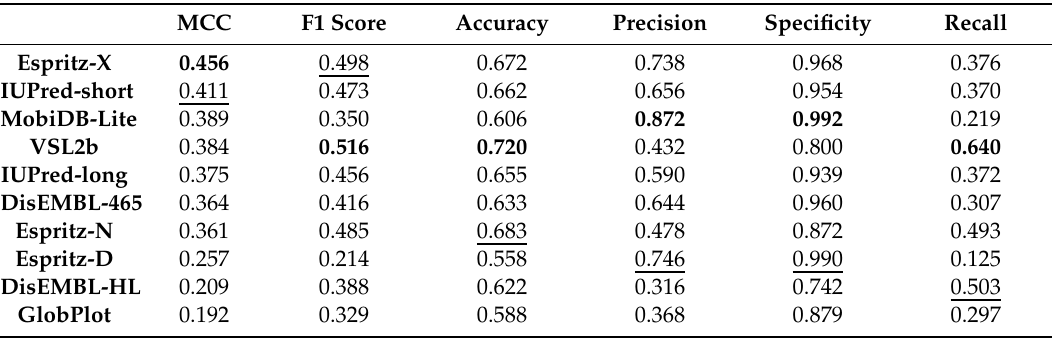
Table 2. Disorder prediction evaluation on proteins with long disordered regions (LDRs) using the majority consensus. Methods are ordered by Matthews Correlation Coe ffi cient (MCC). In bold the best value and underlined the second best for each